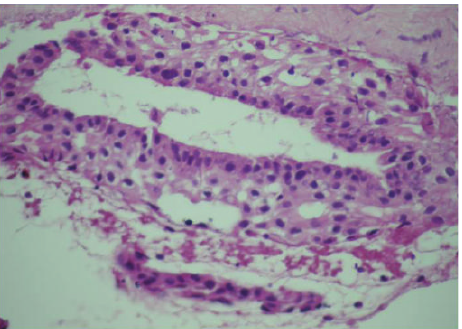
Figure 2: Odontogenic epithelium forming glandular structures (HE × 100).